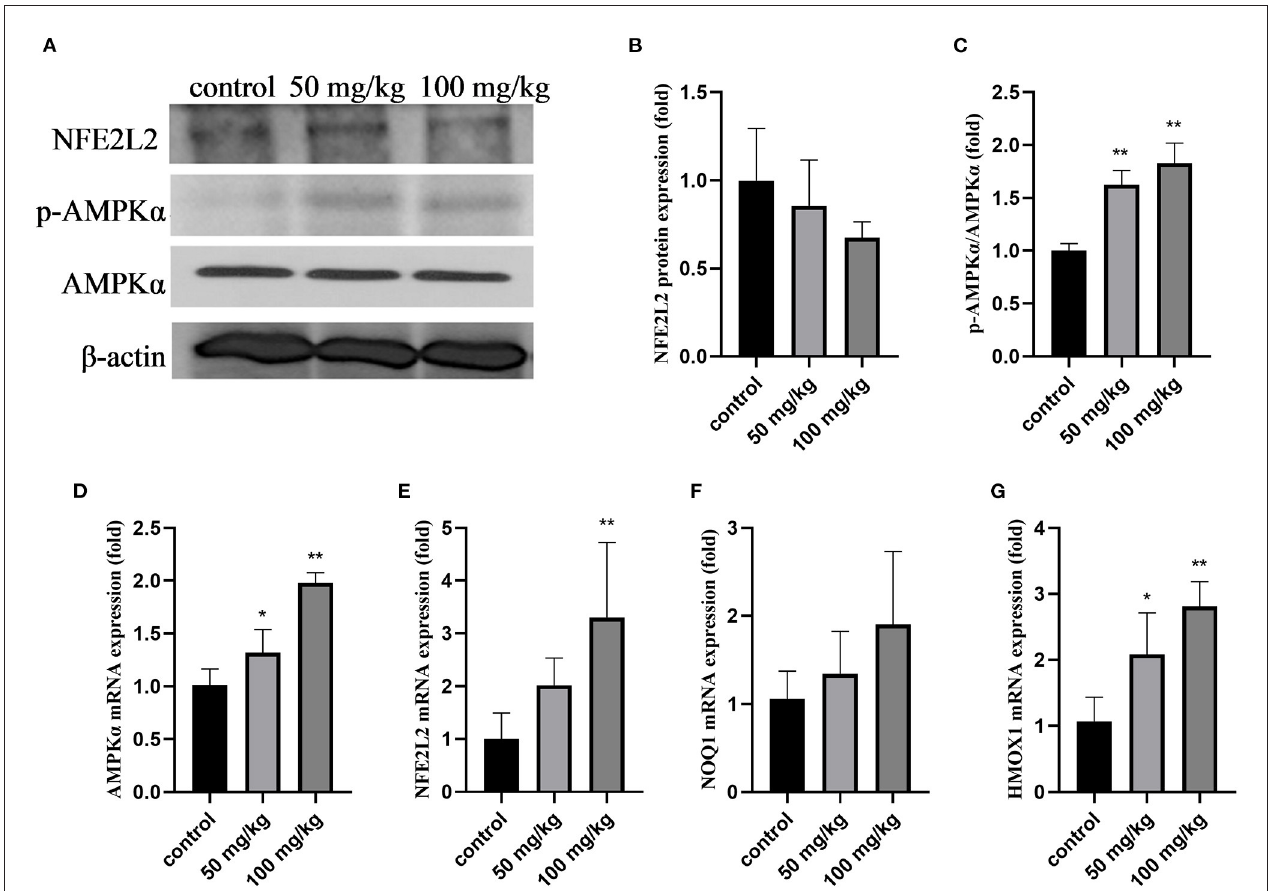
FIGURE 2 | Effects of rutin supplementation on oxidative stress in the mammary gland in sheep during the transition. (A) Western blot analysis of NFE2L2, p-AMPK α and AMPK α . (B) Relative protein abundance of NFE2L2. (C) Relative protein abundance of p-AMPK α /AMPK α . (D–G) Relative mRNA abundance of AMPK α , NFE2L2 , NOQ1, and HMOX1 . Data are presented as means ± SE. * P < 0.05, ** P <